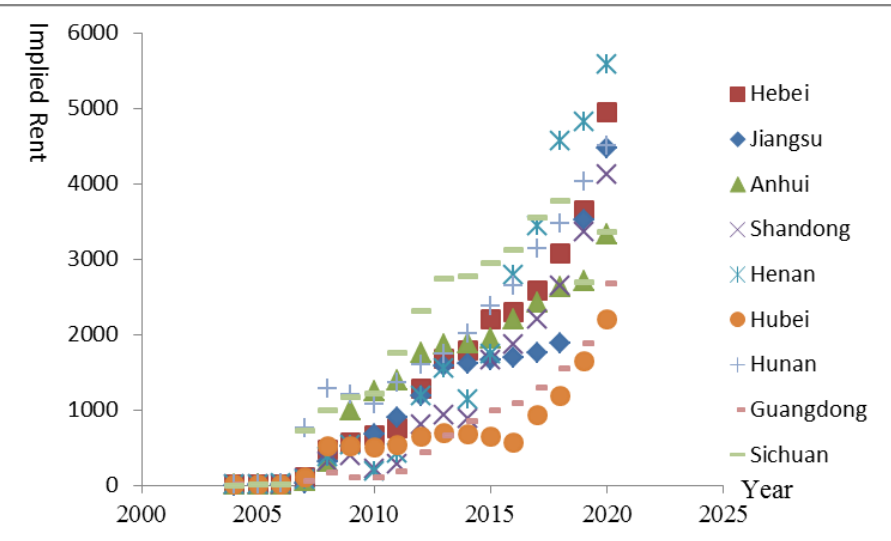
Figure 3. The Increasing Rent Pattern: Premium Series of Subsidized Agricultural insurance in 9 Main Crop-producing Areas during 2004 – 2020. Data Source: China Insurance Yearbook, 2005 – 2021.